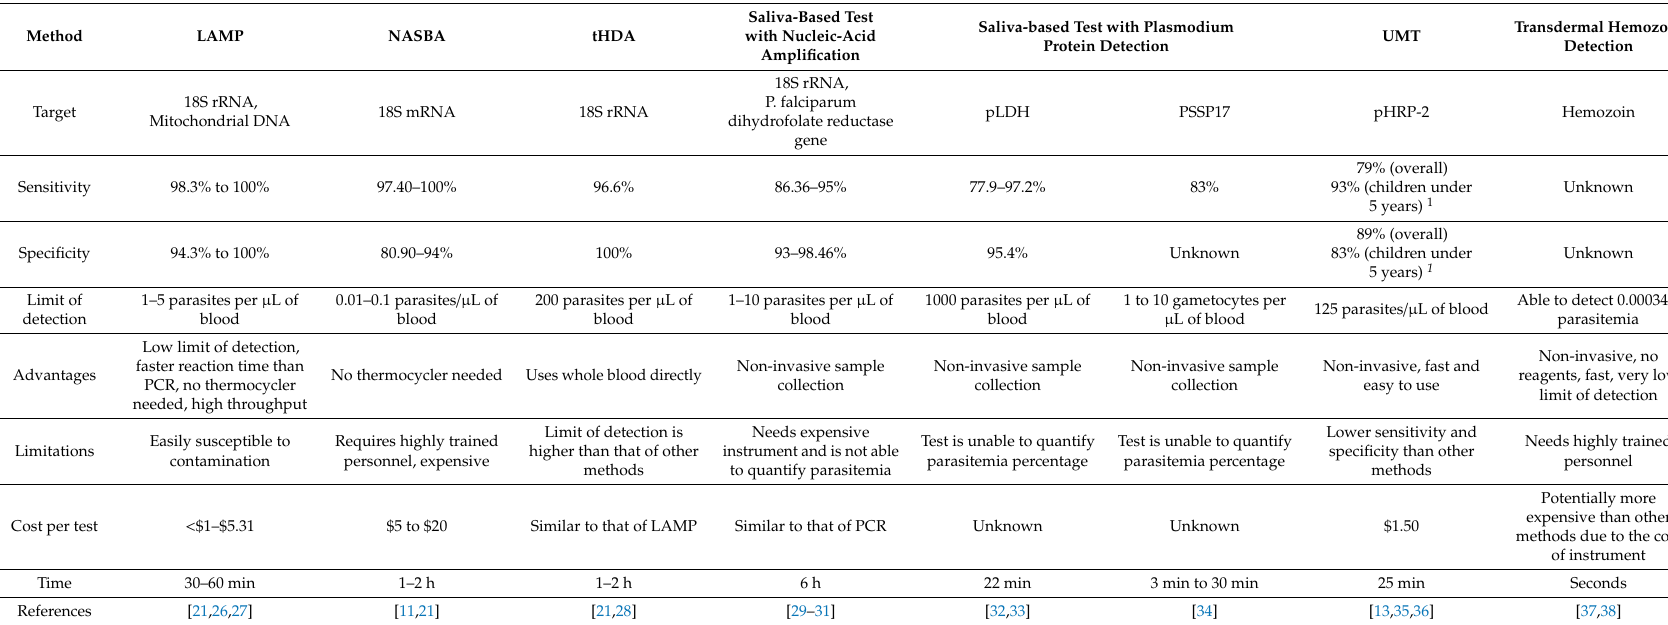
Table 2. Malaria diagnostic options under development. For all methods except the urine malaria test (UMT), sensitivity and specificity are when compared to